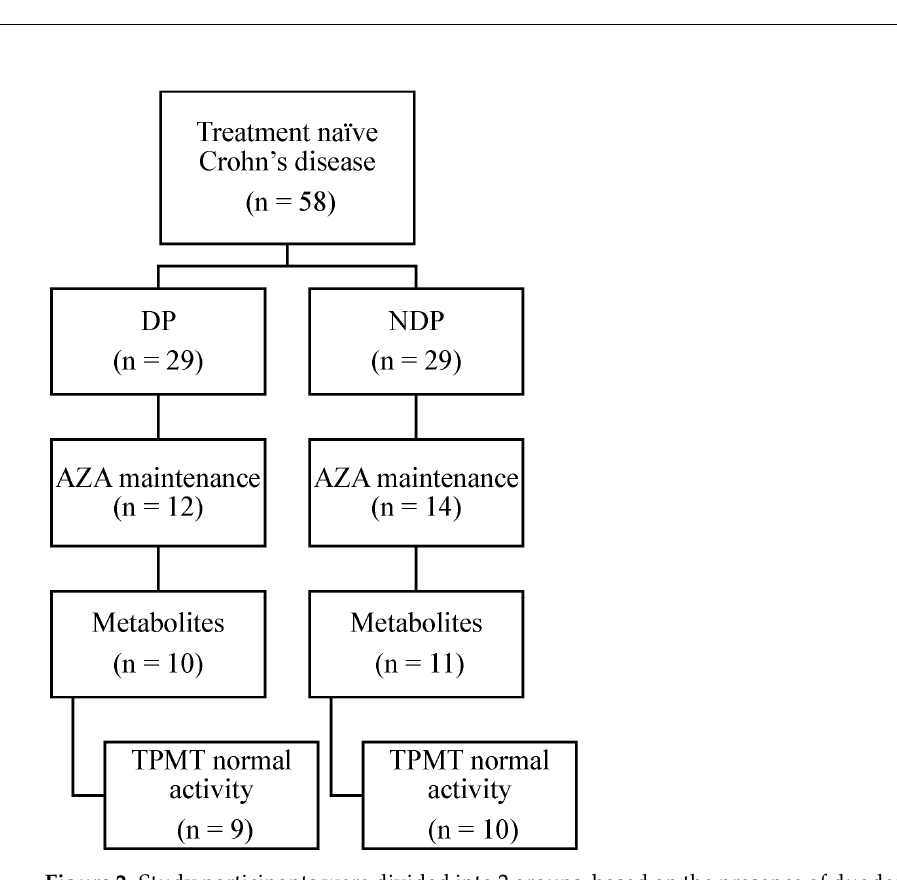
Figure 2. Study participants were divided into 2 groups, based on the presence of duodenal pathology (DP) or no duodenal pathology (NDP) at diagnosis, and further subdivided based on the clinical decision to prescribe maintenance azathioprine (AZA) therapy; TPMT—thiopurine methyltransferase,